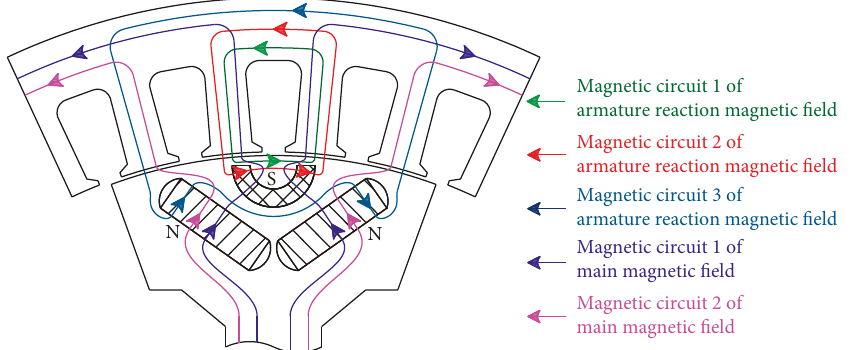
Figure 6: The magnetic circuit of the armature reaction magnetic field.